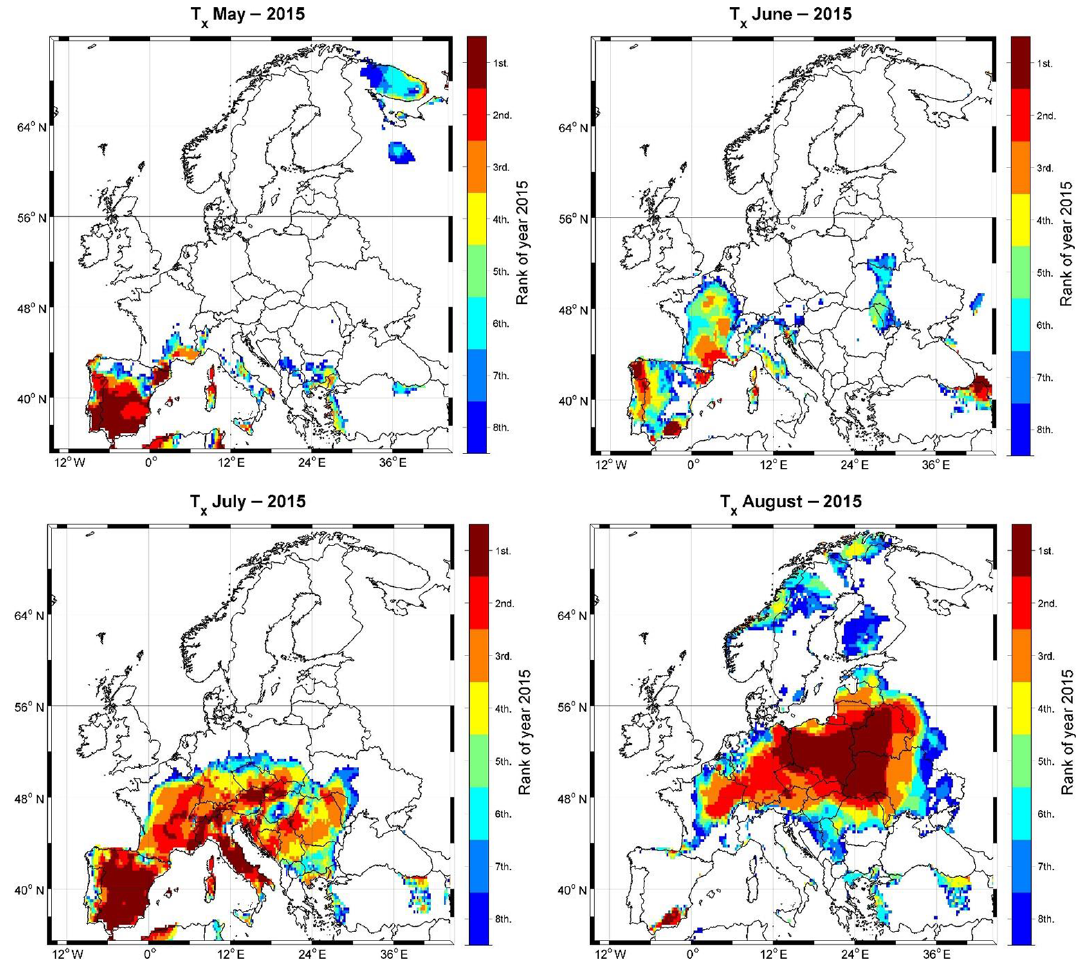
Figure 2. Top-eight ranking of 2015 monthly T x : (a) May; (b) June; (c) July and (d) August. 1 means the warmest month since 1950, 2 signifies the second warmest, etc., and all ranks greater than 8 are shown in white. Analyzed period: